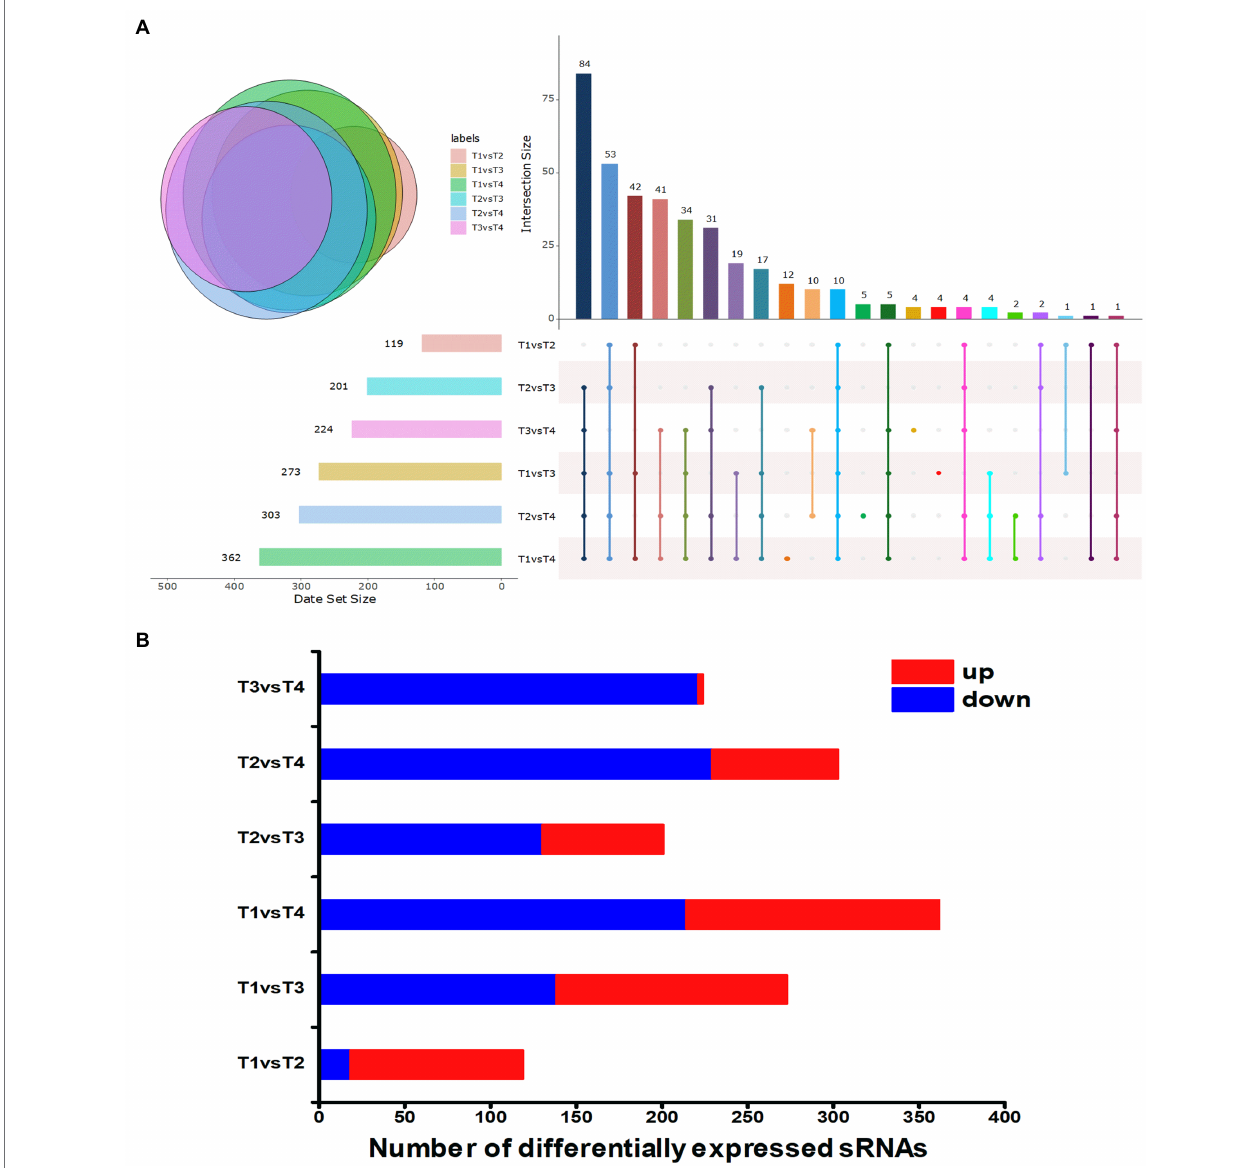
FIGURE 2 | (A) Overlapping analysis diagram of differentially expressed sRNAs. T1, T2, T3, and T4 indicate the late-lag (early-exponential), mid-exponential, late- exponential, and stationary phases, respectively. (B) Statistical graph of differentially expressed sRNAs. The x axis represents the number of differentially expressed sRNAs. Red represents upregulated sRNA, and blue represents downregulated sRNA. T1, T2, T3 and T4 indicate the late-lag (early-exponential), mid-exponential, late-exponential, and stationary phases,